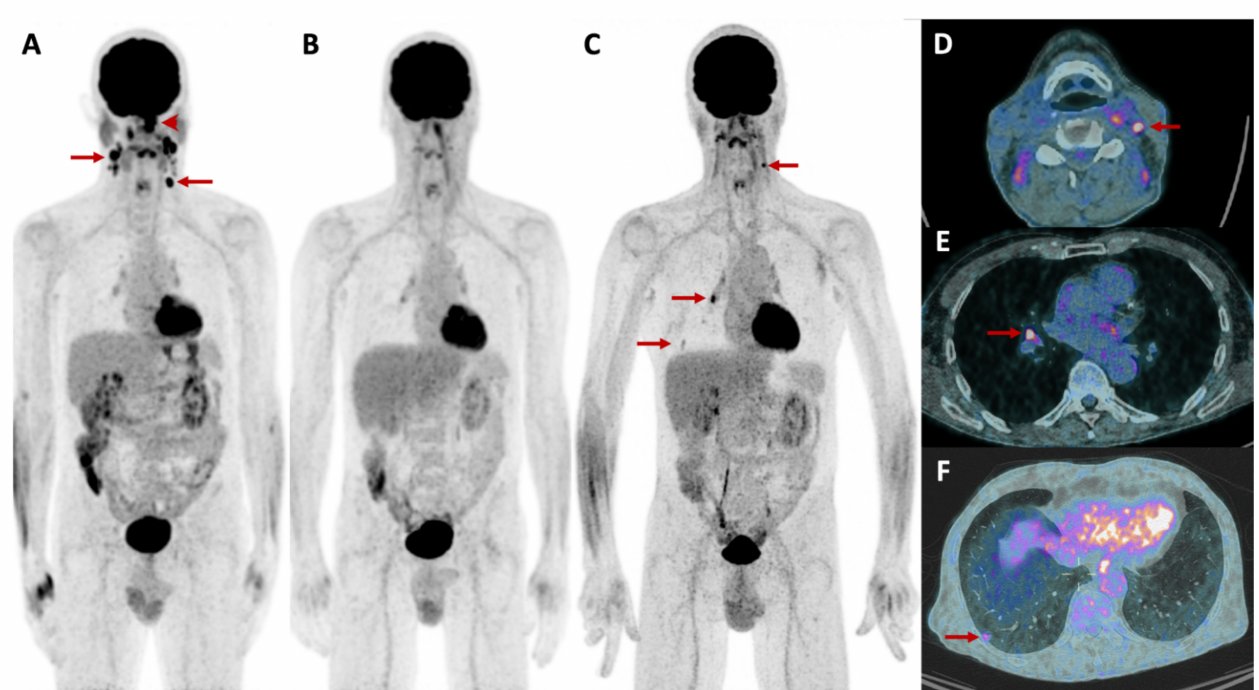
Figure 4. 61-year-old patient with a squamous cell carcinoma of the nasopharynx. The maximum intensity projection at initial diagnosis ( A ), showed the nasopharyngeal lesion with focal FDG uptake (arrowhead) and pathological radiotracer uptake by cervical lymph nodes (arrows). The patient was in complete remission after radio-chemotherapy ( B ). Six months later the patient presented an oligo-recurrence ( C , arrows), as shown by the fusion images, with local left cervical lymph node recurrence ( D , arrow), and new metastatic lesions in a right hilar lymph node ( E , arrow) and in the lung ( F ,